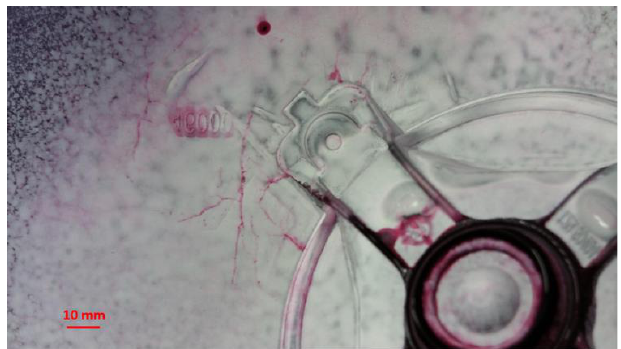
Figure 1. Fractured surface of casting mold.